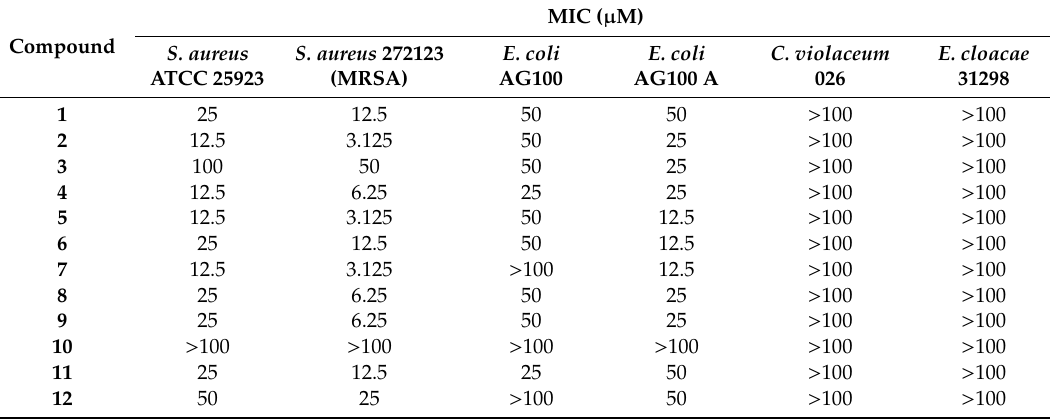
Table 1. Minimum inhibitory concentrations (MICs) of the ligands and their metal complexes on Staphylococcus aureus ATCC 25923, S. aureus 272123, Escherichia coli AG100, E. coli AG100 A, Chromobacterium violaceum 026, and Enterobacter cloacae 31298. MIC ( µ M) Compound S. aureus